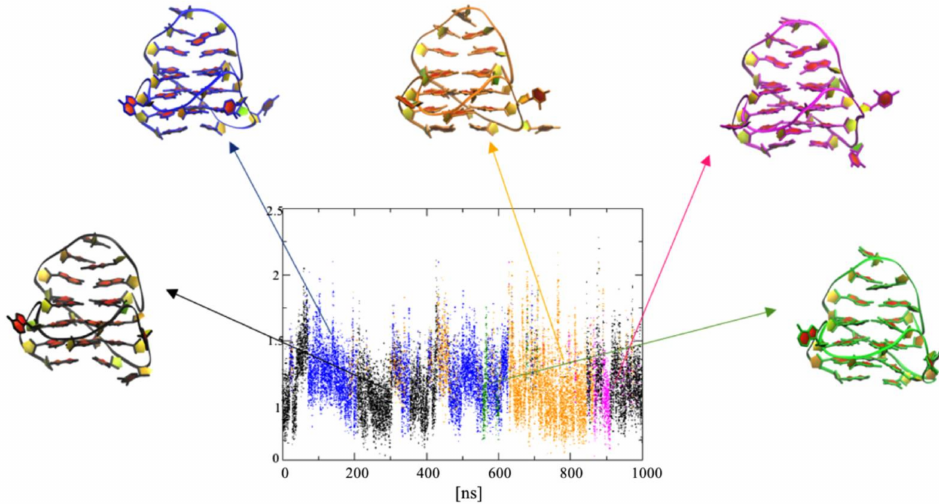
Figure 9. Representation of the conformational clusters obtained by clustering analysis for G-quadruplex-ligand 3 complex. RMSD-based clustering, with a cut-off of 2.3 Å, identified five clusters. Cartoon representations of side view of cluster centers are illustrated (top 3 (cid:48)